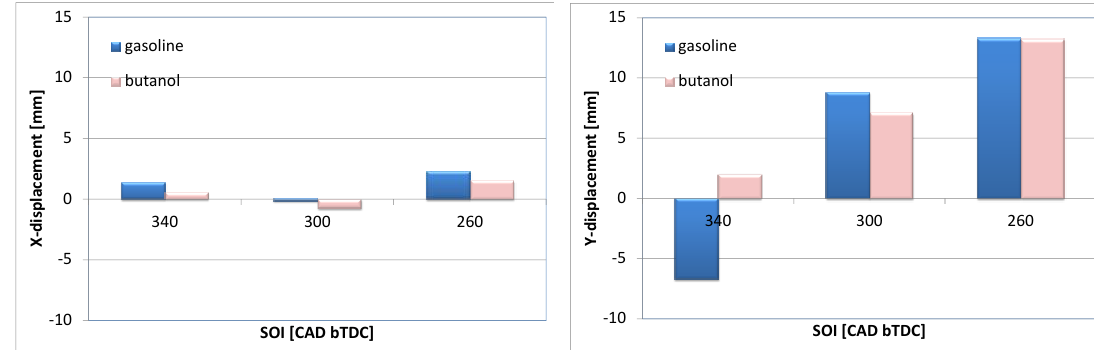
Figure 13. Diffusive flames displacement.